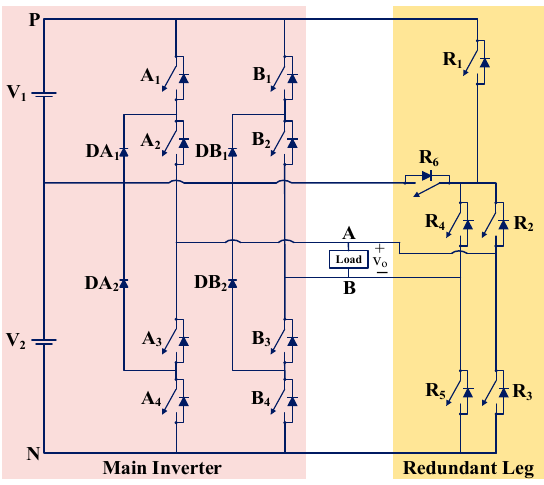
Figure 49. Single-phase five-level FT MLI [34].